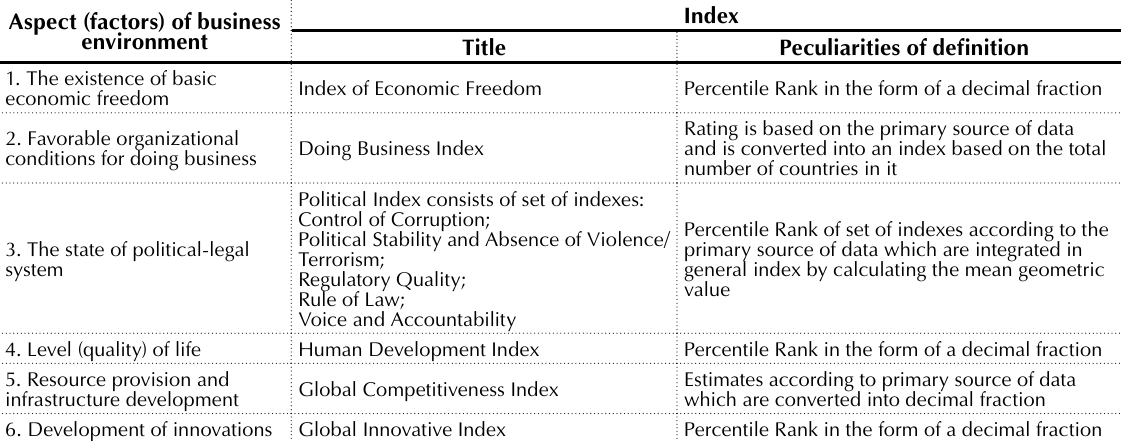
Aspect (factors) of business